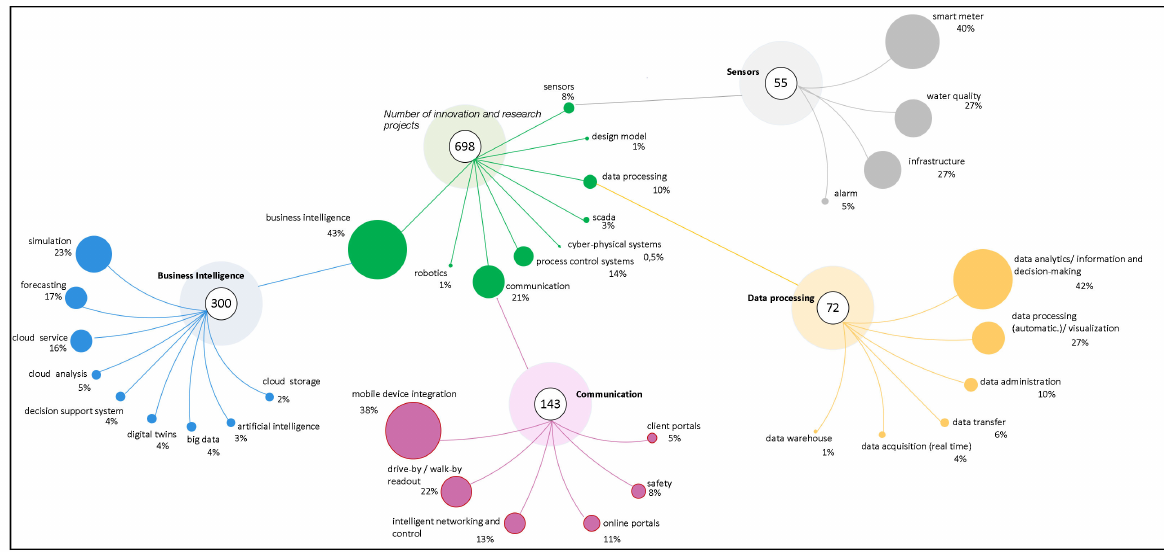
Figure 5. Technological distribution of identified digitization elements ( n =